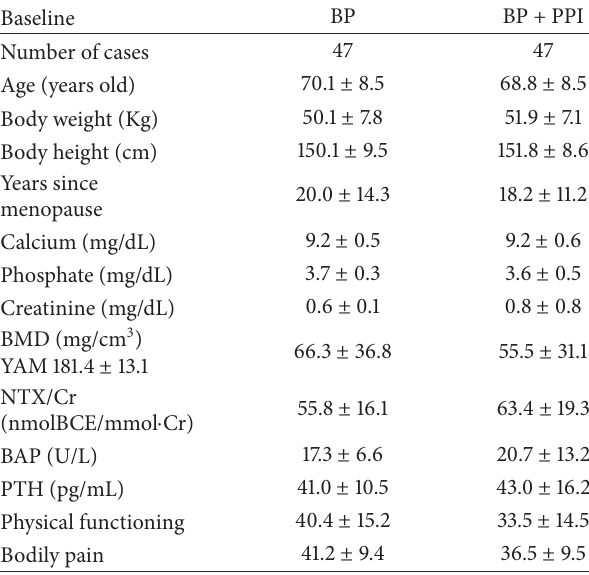
Table 2: The background data, including age, body weight, body height, years since menopause, serum levels of calcium, phosphate and renal function indicated by creatinine, and the measured numeric values of the BMD, NTX/Cr, BAP, PTH, and the physical parameters at the baseline.